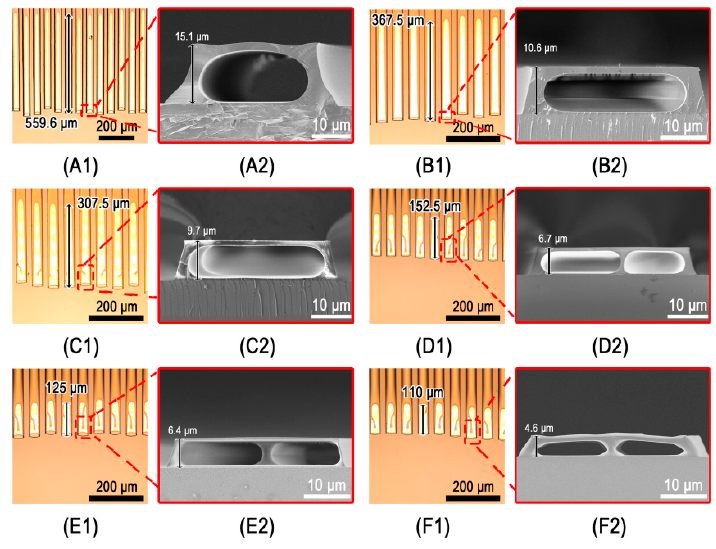
Figure 3. Microchannels fabricated in trapezoid microgrooves with a bottom width of about 40 µ m and different heights: ( A1 , A2 ) 15.1 µ m; ( B1 , B2 ) 10.6 µ m; ( C1 , C2 ) 9.7 µ m; ( D1 , D2 ) 6.7 µ m; ( E1 , E2 ) 6.4 µ m; ( F1 , F2 ) 4.6 µ m; ( A1 – F1 ) the microscope images of microchannels; ( A2 – F2 ) the cross-sectional images of microchannels corresponding to ( A1 – F1 ).